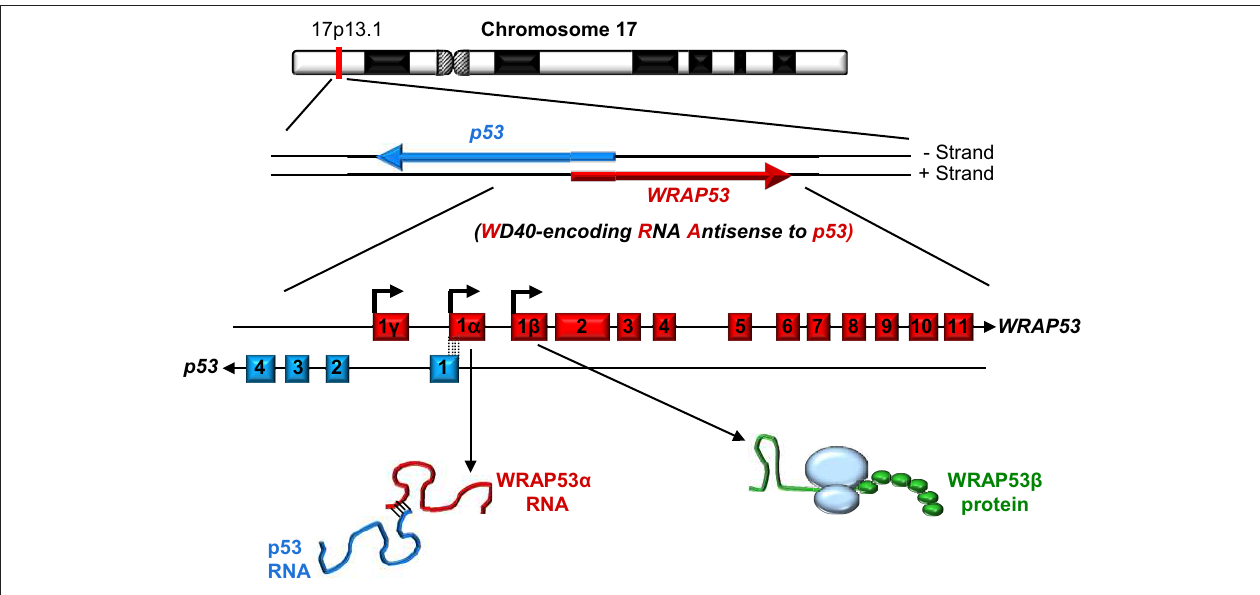
FIGURE 1 | The WRAP53 and p53 genes and their gene products. The arrows indicate the direction of transcription and the dotted lines the exon overlap between these genes.